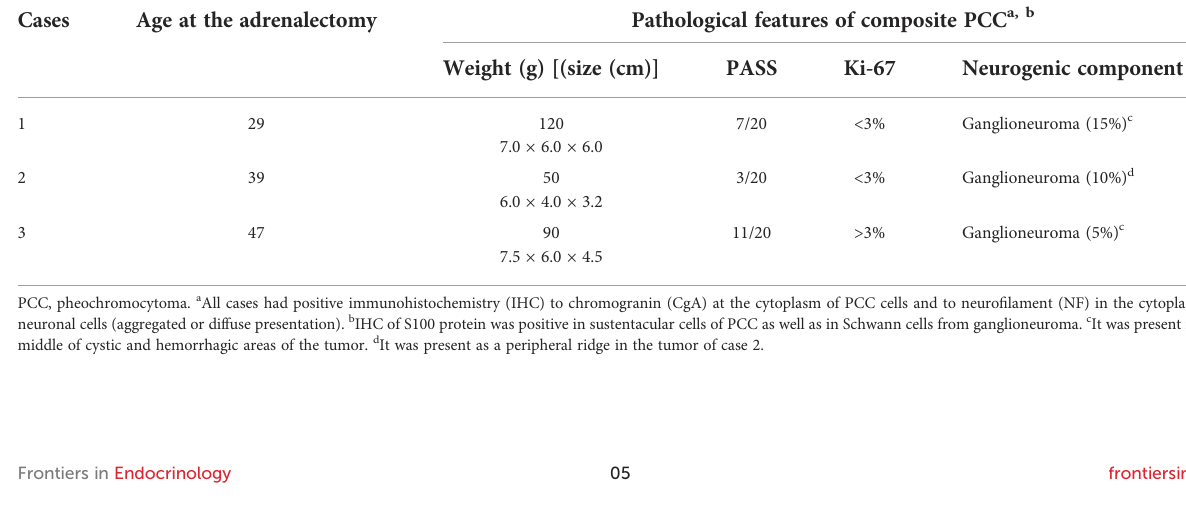
TABLE 2 Pathological features of three cases with composite PCC.